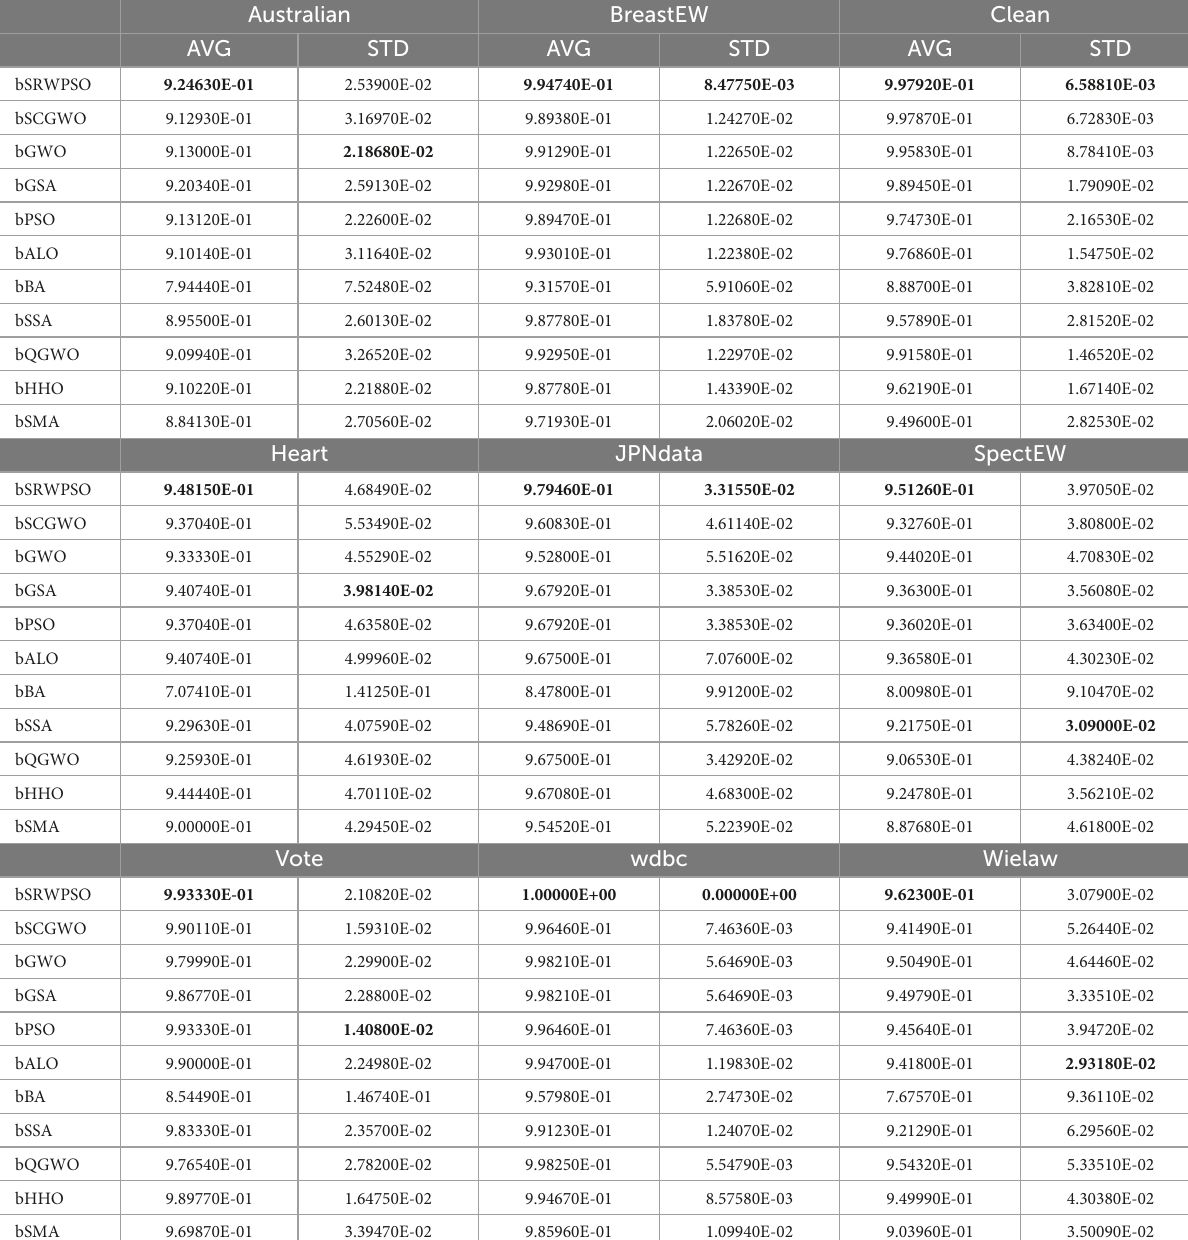
TABLE 13 The analysis results of